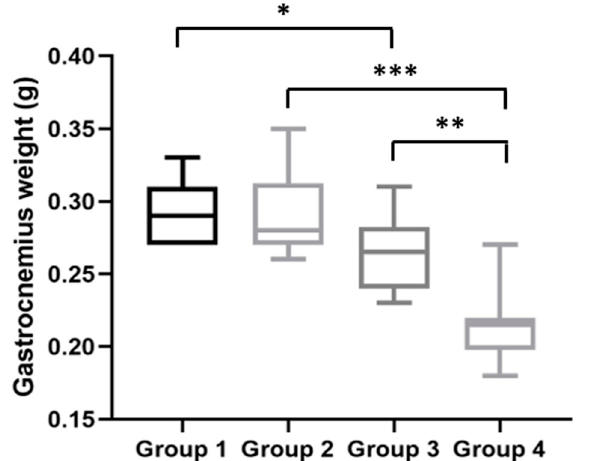
Figure 6. Gastrocnemius muscle weights at the time of sacrifice. HPV + mice had inferior gastrocnemius weights than matched HPV − mice—Group 3 versus Group 1: * p < 0.05; Group 4 versus Group 2: *** p < 0.001. Additionally, Group 4 had a lower gastrocnemius weight than Group 3 ( ** p < 0.01). Group 1: HPV − without DMBA application ( n = 10); Group 2: HPV − with DMBA application ( n = 10); Group 3: HPV + without DMBA application ( n = 10); Group 4: HPV + with DMBA application ( n = 10).